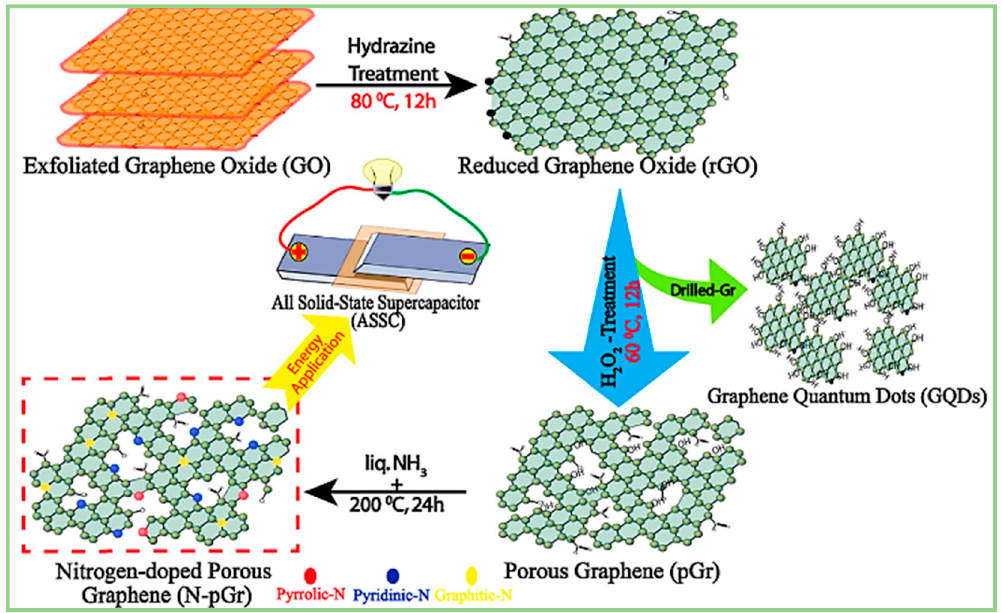
Figure 8. Graphical representation of the synthesis of N-pGr and graphene quantum dots (GQDs) and their potential application for the fabrication of the asymmetric supercapacitors (ASSC) device. Reprinted with permission from [136], Copyright 2017, Elsevier.